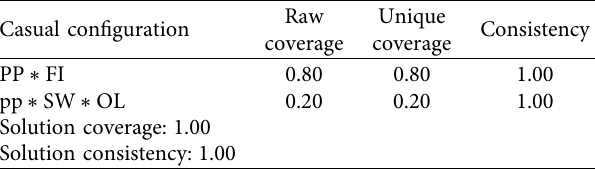
(c) Cross-tab showing “PP ∗ FI” or “pp ∗ SW ∗ OL” as